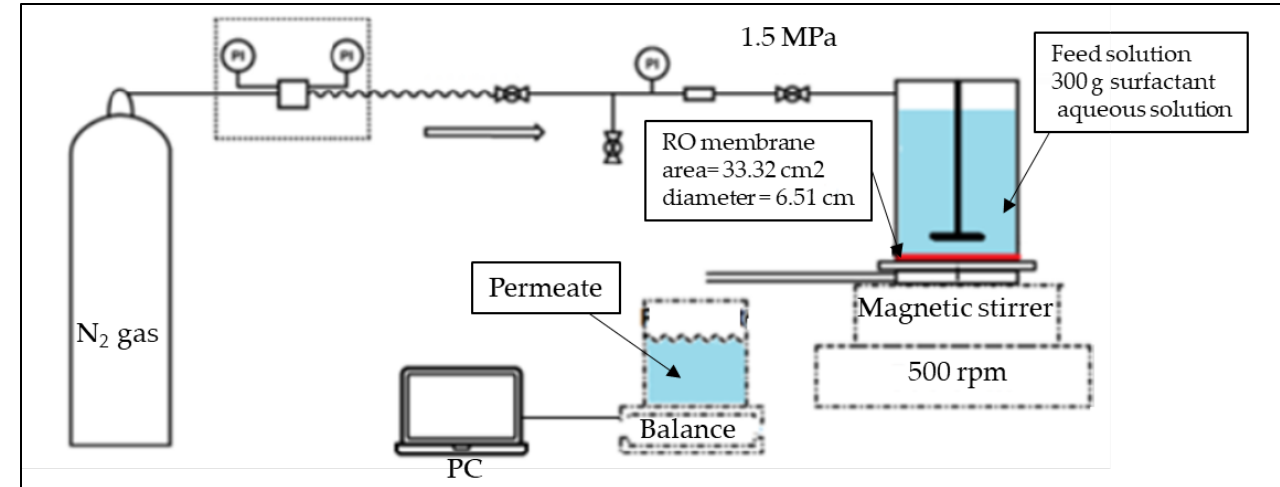
Figure 1. Schematic representation of the RO separation setup.